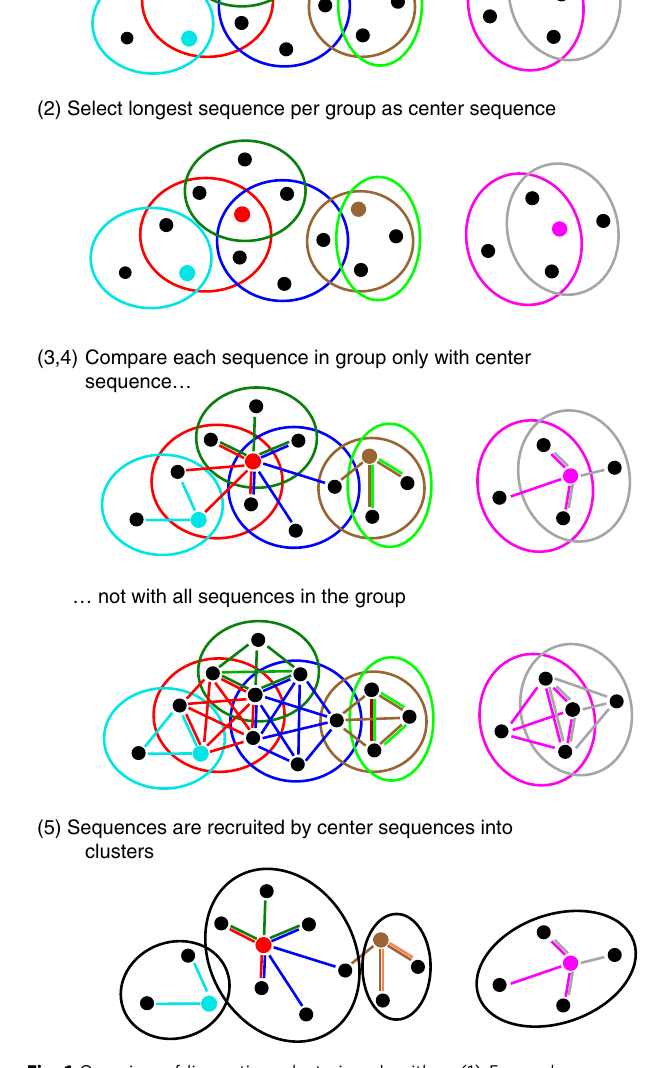
Fig. 1 Overview of linear-time clustering algorithm. (1) For each sequence Linclust selects m k -mers (with the lowest hash function values). It sorts the k -mers alphabetically in quasi-linear time to fi nd the groups of sequences sharing a k -mer (colored sets) and (2) it selects the longest sequence per k -mer group as center. (3,4) It compares each sequence (in three consecutively slower and more sensitive steps) only with the center sequences it shares a k -mer with, not with all sequences it shares a k -mer with. It therefore needs to compute at most m comparisons per sequence and mN in total. Pairs that pass the clustering criteria are linked by an edge. (5) The sequences are clustered in time O ( mN ) using a greedy incremental algorithm that fi nds clusters whose members all have an edge with a representative sequence. For a more details see Fig.